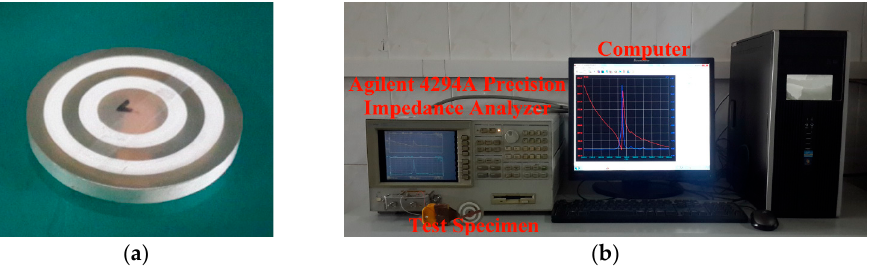
Figure 4. Experimental setup: ( a ) the fabricated specimen; ( b ) the impedance test system.